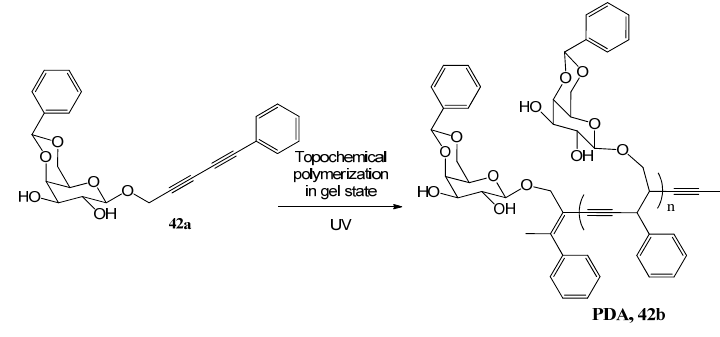
Figure 32. Galactose derived poly diacetylenes.